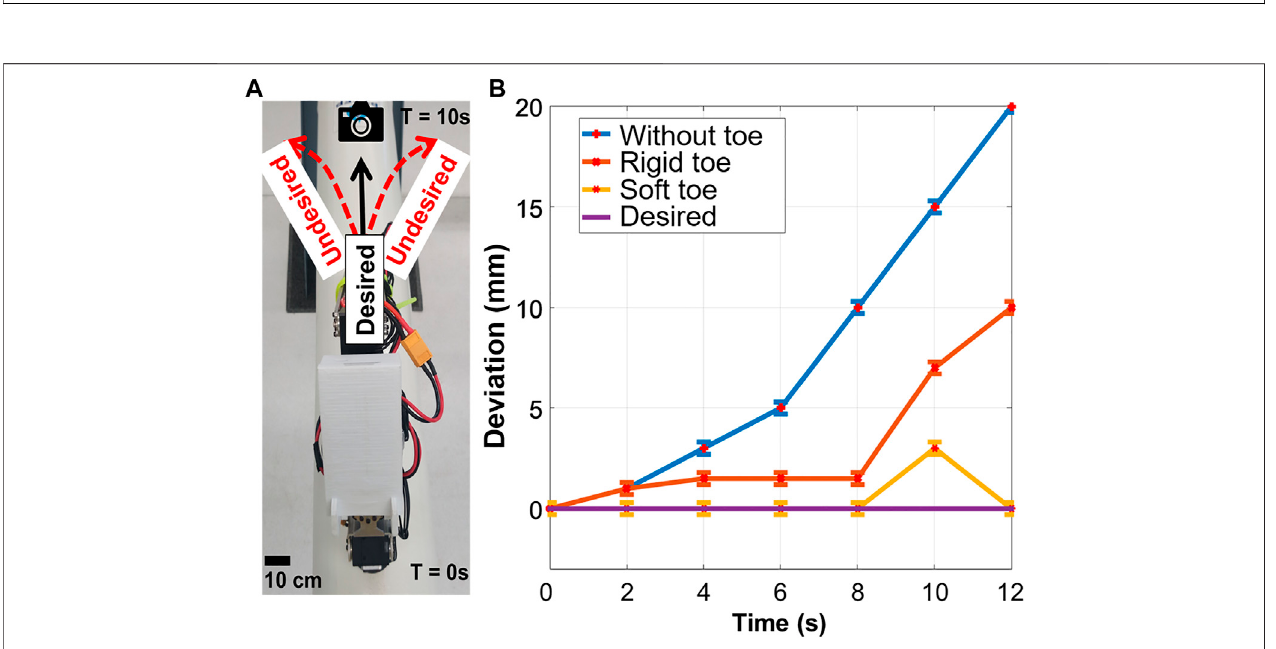
FIGURE 12 | (A) Rigid-soft foot leverages on the adhesion and friction components (F x,y ) upon attachment to the metal pipe. (B) The robot performs high-speed bidirectional crawling on a metal pipe with a speed of 100 mm/s using the rigid-soft feet. A supplementary video of the experiments can be viewed at http://www. manoonpong.com/EROFT/videoS1.mp4.